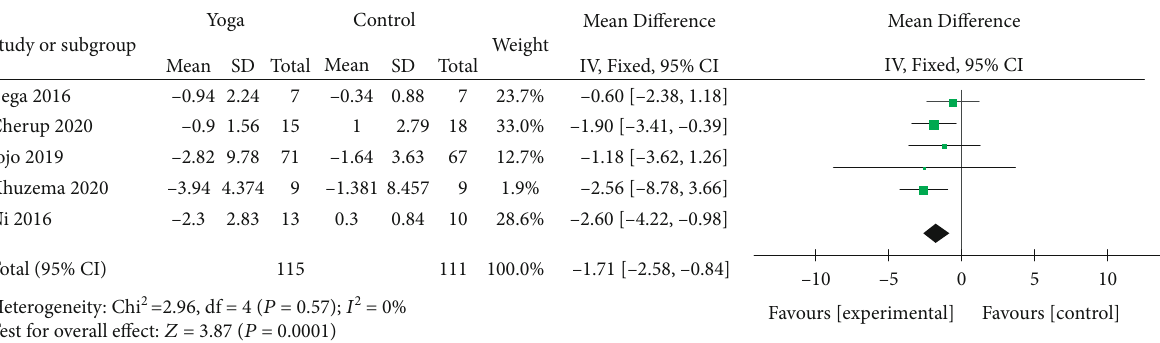
Figure 6: Forest plot from the meta-analysis of yoga on functional mobility.